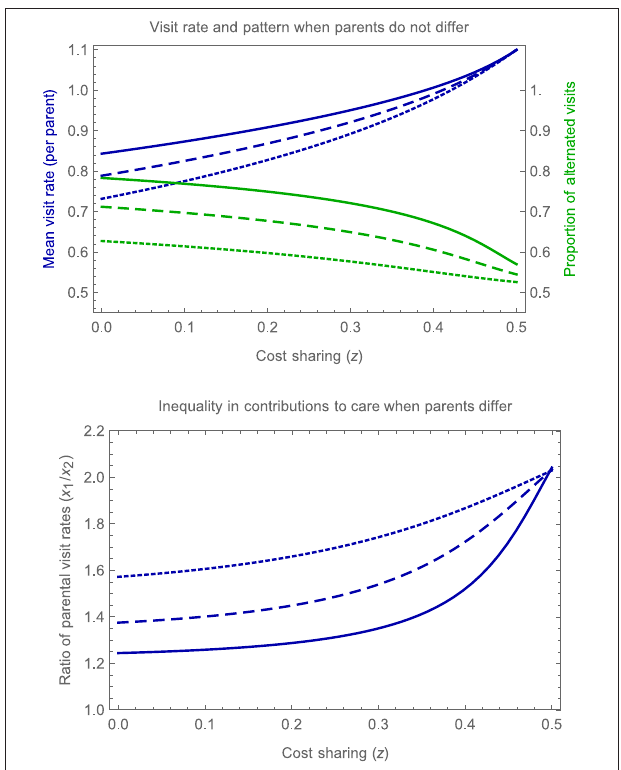
FIGURE 9 | Impact of cost sharing on turn-taking. The upper panel shows, for an illustrative symmetrical case in which parents do not differ from one another, the mean visit rate per parent (in blue) and proportion of alternated visits (in green) as a function of the extent of cost sharing ( z ), for three different values of d , the probability of detecting a partner’s visists ( d = 0.95, solid curves; d = 0.85, dashed curves; d = 0.7, dotted curves). Other parameter values are b = 1, c = 0.2, h = 1, and r = 0.2. The lower panel shows, for an illustrative asymmetrical case in which parent 1 enjoys a recovery rate r 1 = 0.4 that is higher than that of the second parent r 2 = 0.2, the ratio of mean parental visit rates ( x 1 / x 2 ), again as a function of the extent of cost sharing ( z ), for the same three values of d . Other parameter values are as specified for the upper